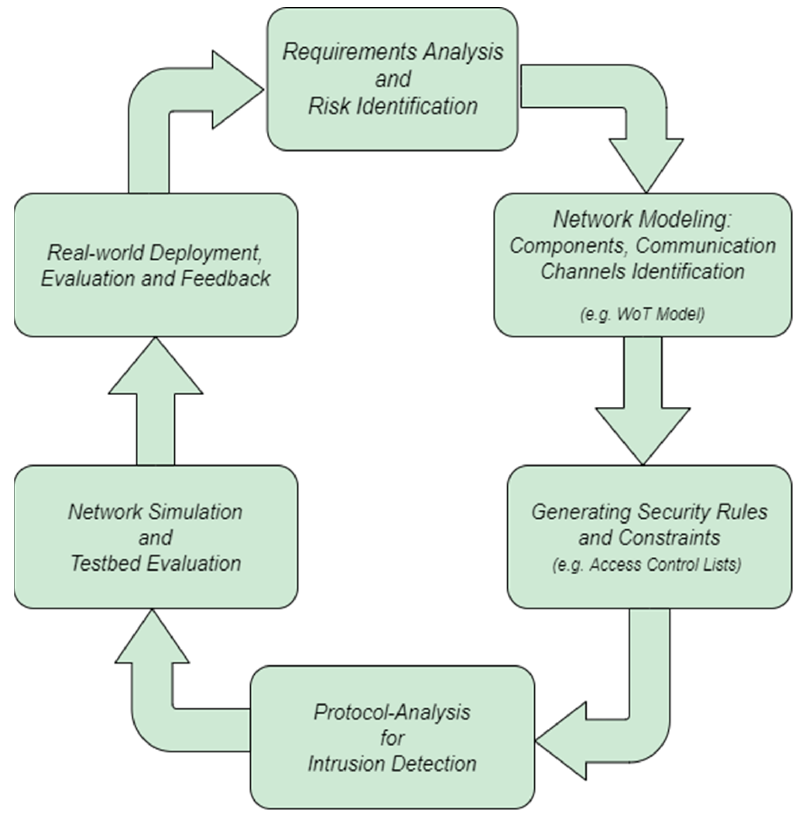
Figure 4. Structure of the KIVEP process pipeline and methodology.